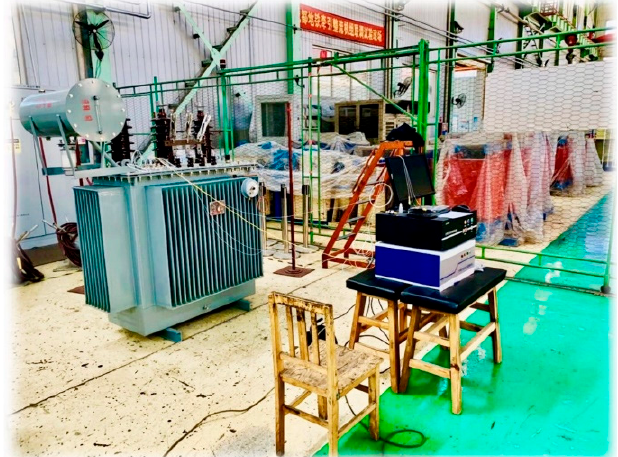
Figure 8. Field application of the DOFS integrated power transformer.